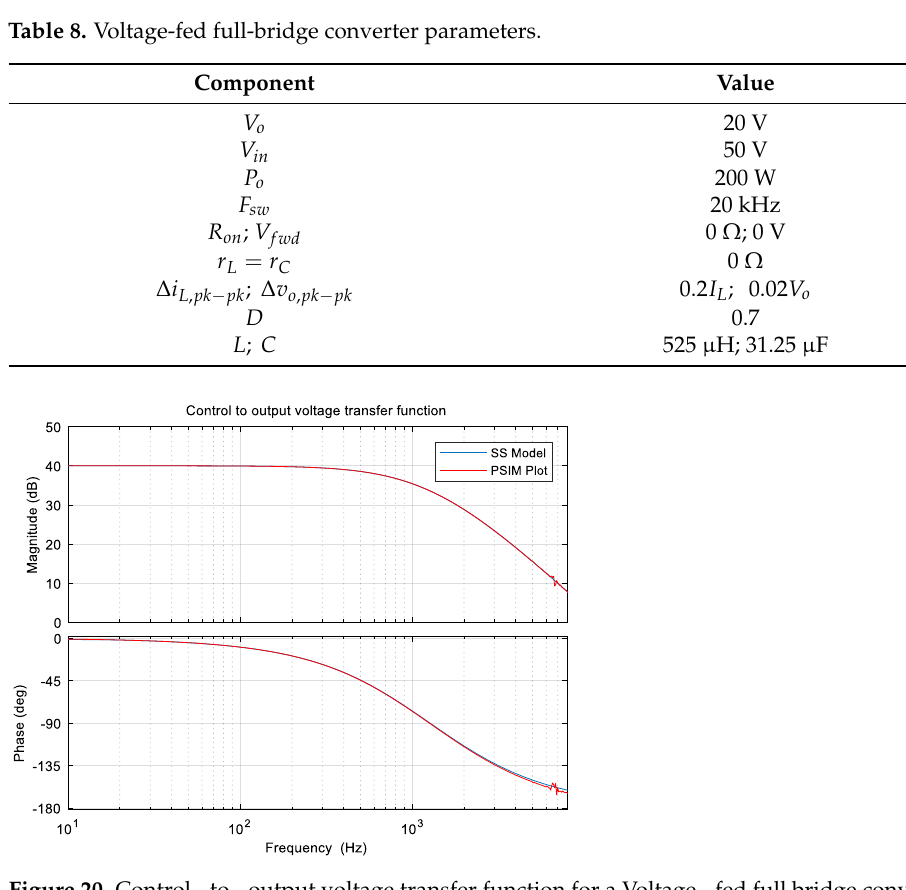
Table 8. Voltage-fed full-bridge converter parameters .